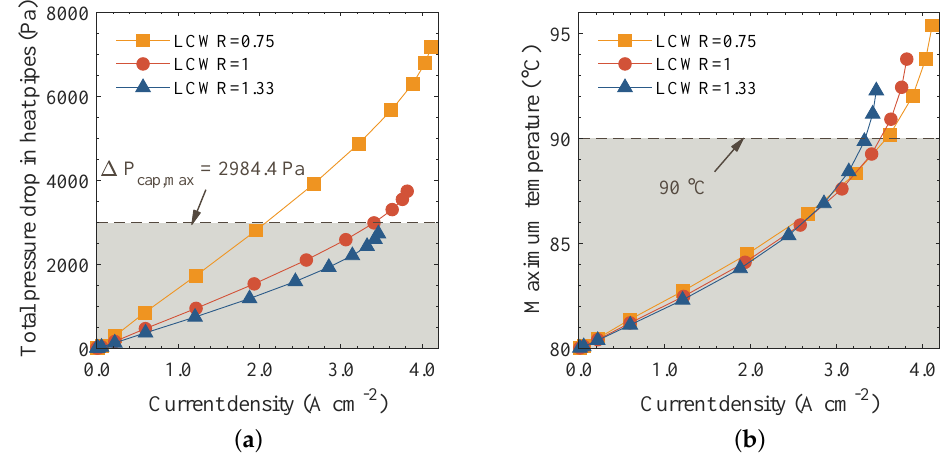
Figure 10. Comparison of the operating range limits for different LCWRs: ( a ) Maximum heat transfer capability. ( b ) Maximum temperature